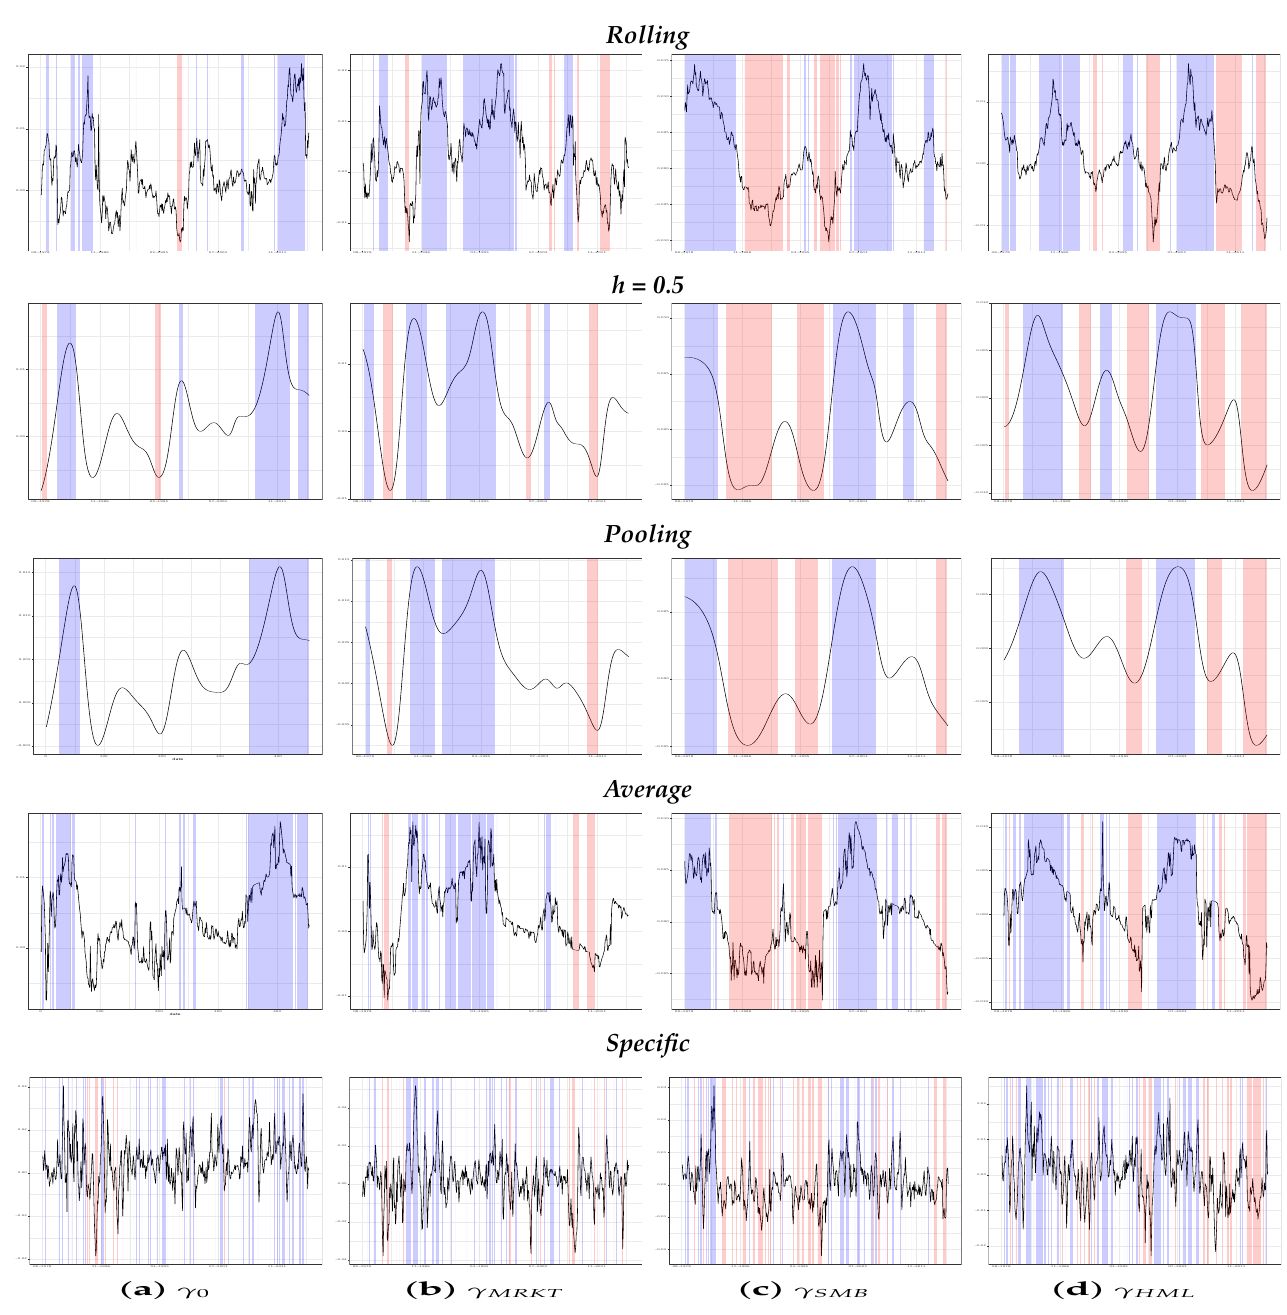
Figure 5. Comparison of γ s significance of different approaches—55 portfolios. Note: The figure provides a significance analysis of the estimates of risk premium estimates. The blue areas are periods in which the estimates are statistically positive at a 5% level of significance, while the red ones identify periods in which the estimates are negative. The series were computed using different approaches: Rolling window ( FMcB approach), h = 0.5; Polling a single value of h coming from the poll average across assets and time (Equation (7)); Average , a unique time-varying bandwidth coming from the average of h across assets (Equation (8)); Specific , multiple time-varying bandwidths, one for each asset and time. The choice of the optimal bandwidth parameter h opt was made using the kernel t approach, as discussed in Equation